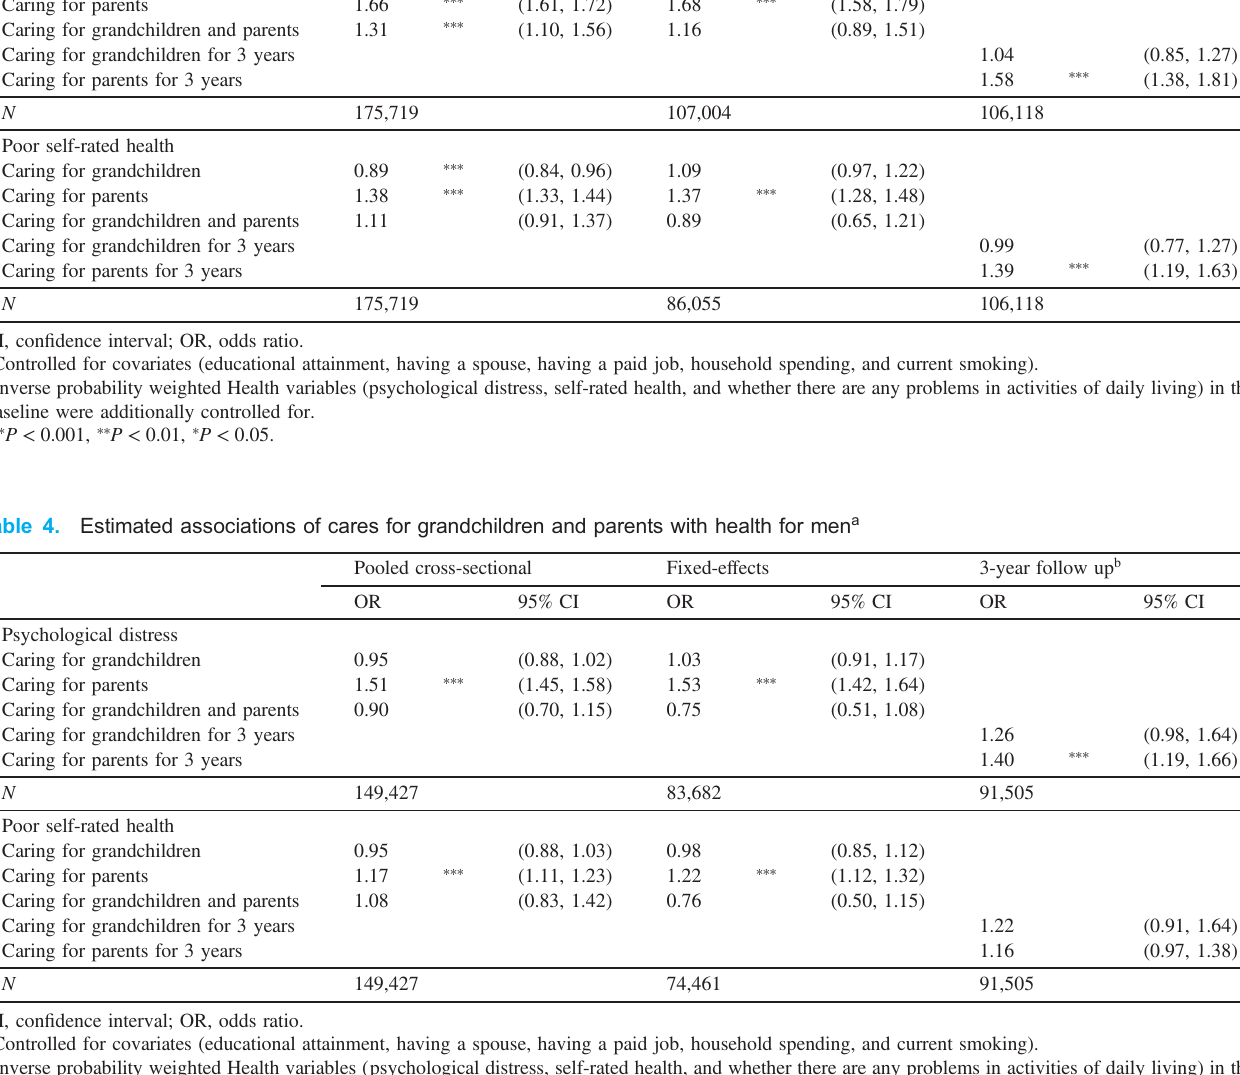
Pooled cross-sectional Fixed-e ff ects 3-year follow up b